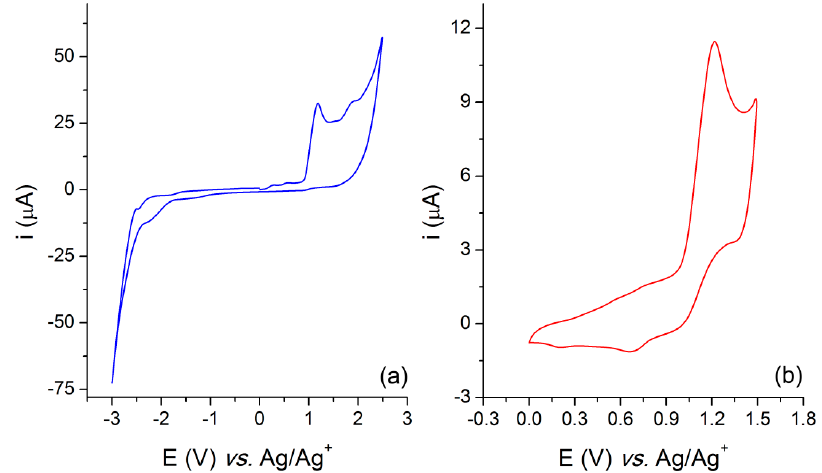
Figure 1. ( a ) Cyclic voltammogram of spiropyran 7 on a glassy carbon electrode in 0.1 TBAPF 6 / CH 2 Cl 2 Figure 1. (a) Cyclic voltammogram of spiropyran 7 on a glassy carbon electrode in 0.1 at 100 mV s − 1 and ( b ) the oxidation peak TBAPF 6 /CH 2 Cl 2 at 100 mV s -1 and (b) the oxidation peak detail.